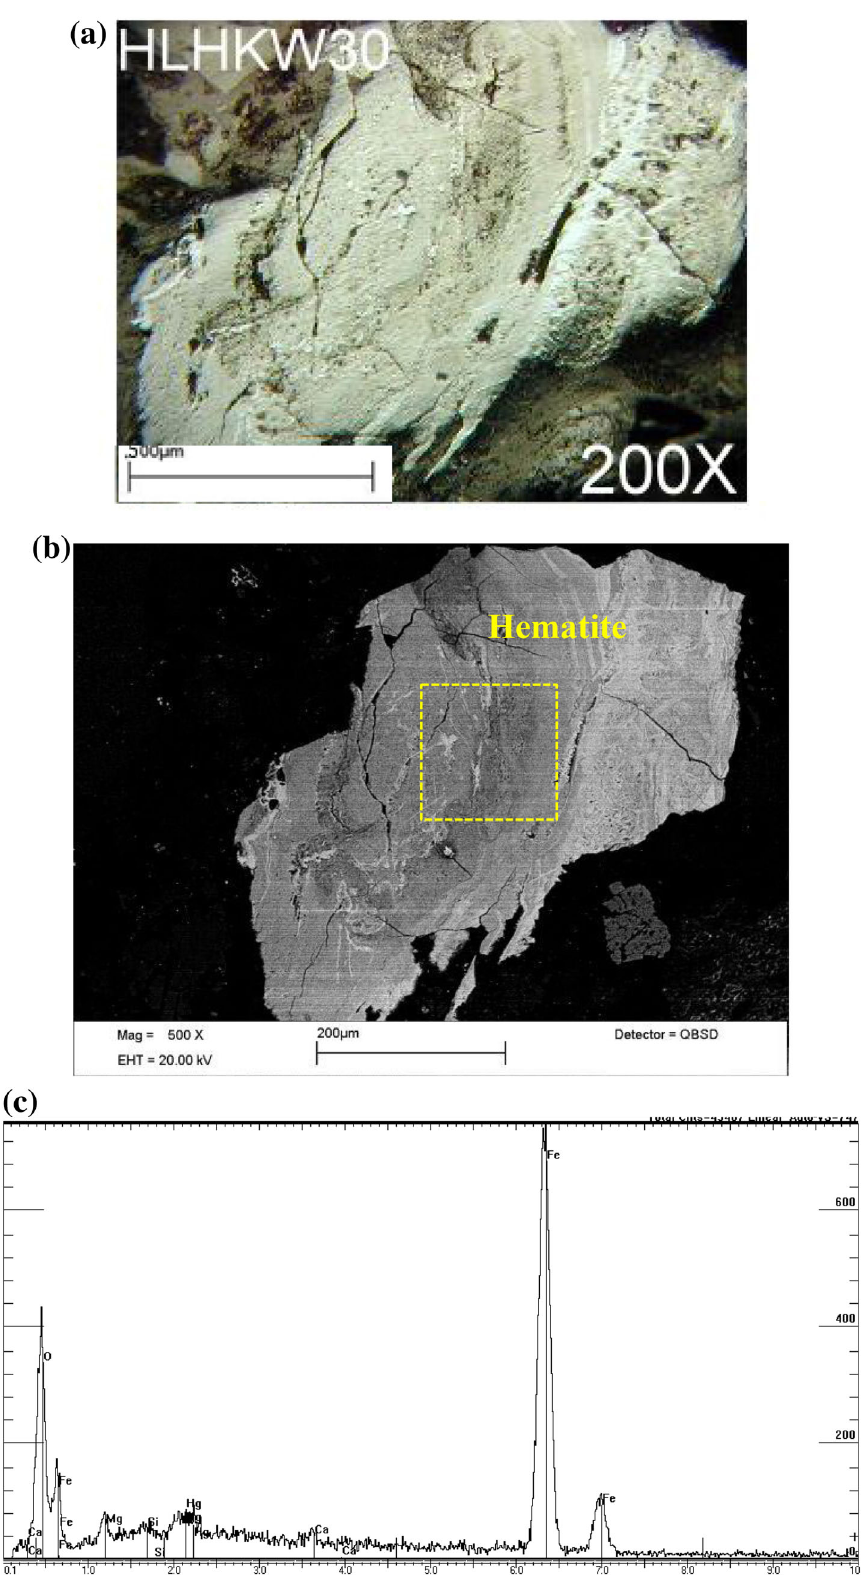
Fig. 4 Hematite in the Huolinhe coal. a Optical microscopy, reflected light; air; polarized light;200 9 . b SEM backscattered electron image. c X- ray energy spectrum diagram of box in b , scanning area: 150 l m 9 150 l